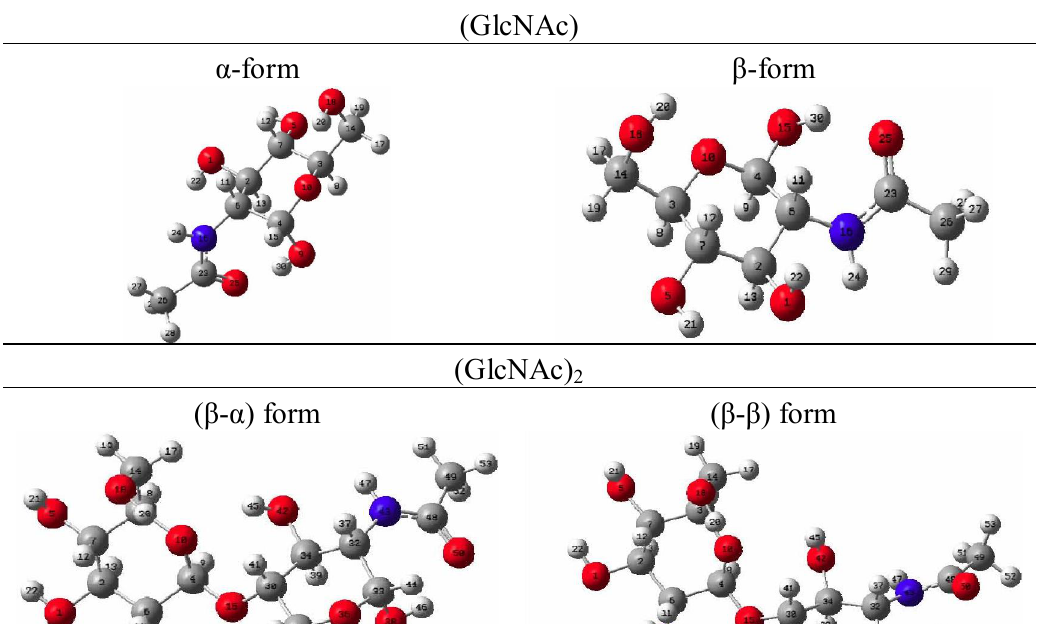
Figure 5. B3LYP optimized geometrical structure of (GlcNAc) and (GlcNAc)